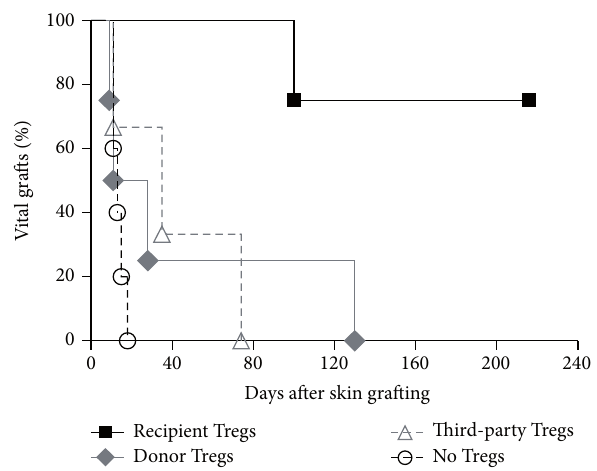
Figure 5: Recipient but not donor and third-party Treg treatment induces donor-specific tolerance. Donor-specific tolerance was assessed by grafting of donor and third-party skin 4–6 weeks after BMT. Donor skin graft survival was significantly prolonged in BMT recipients treated with recipient Tregs ( ◼ recipient Tregs, 𝑛 = 4 ; X donor Tregs, 𝑛 = 4 ; 󳵻 third-party Tregs, 𝑛 = 3 ; I no Tregs, 𝑛 = 5 ). Survival was calculated according to the Kaplan-Meier product limit method and compared between groups using the log- rank test ( 𝑝 < 0.05 for recipient Tregs versus all other